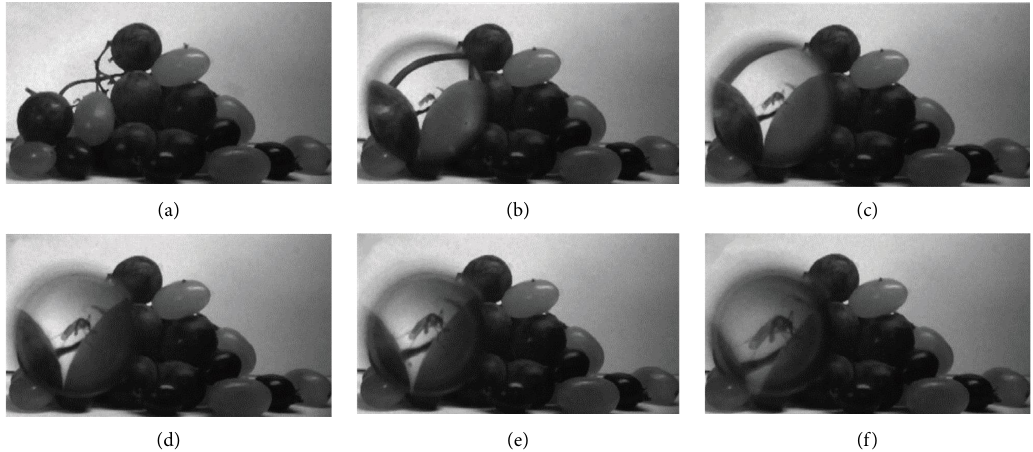
Figure 11: Drosophila imaging at diferent foveated focal lengths at 546nm. (a) 16mm focal length peripheral channel imaging without a foveated zoom lens group. (b)–(f) 2.6 × , 4 × , 5.4 × , 6.6 × , 9 × foveated zoom imaging with foveated zoom lens group.